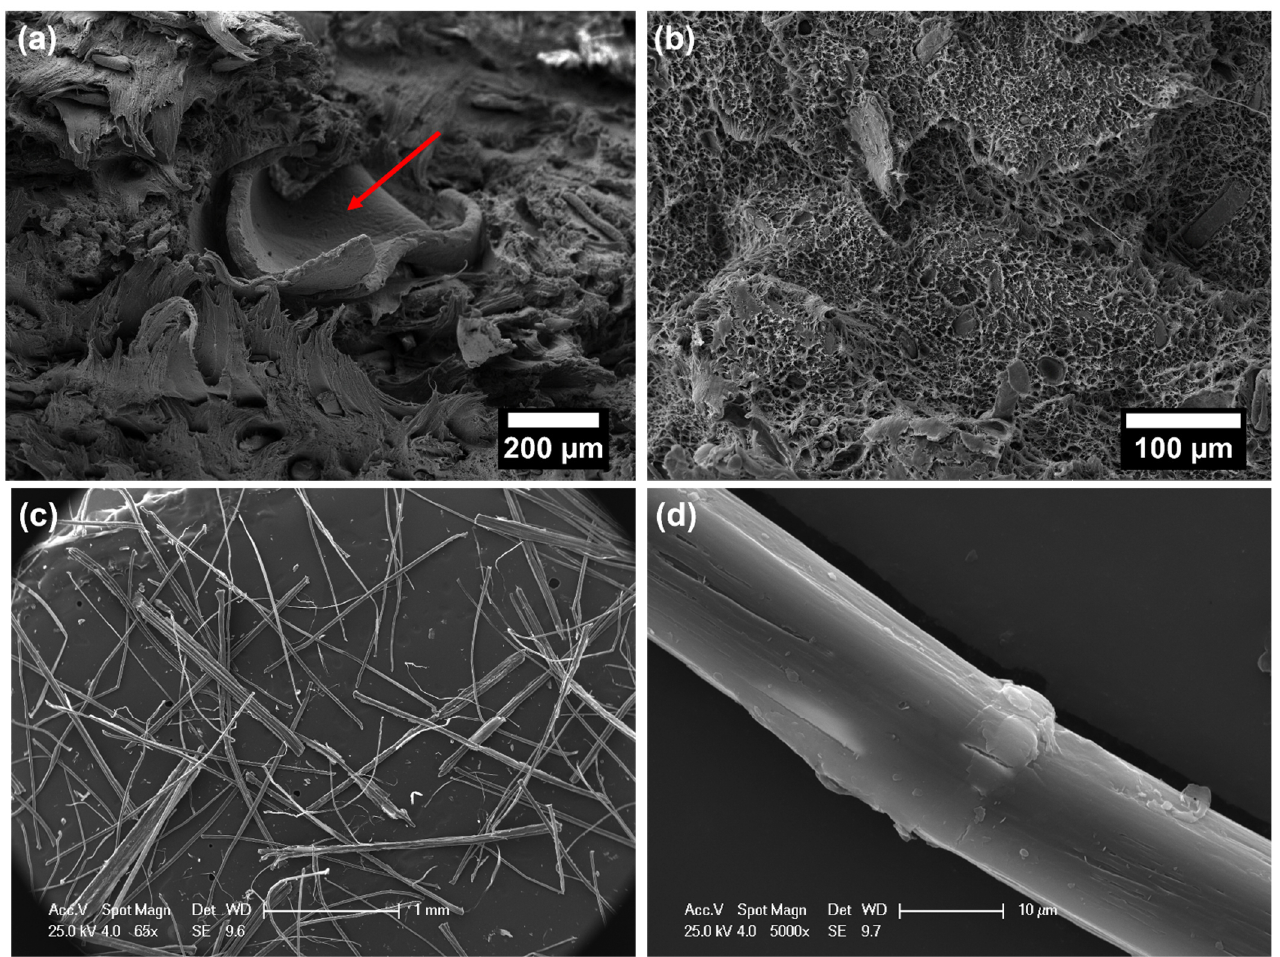
Figure 5. SEM micrographs of neat EcoAllene: ( a ) after tensile test and ( b ) after Charpy impact test; ( c , d ) representative SEM micrographs of as-received chopped flax fibres.